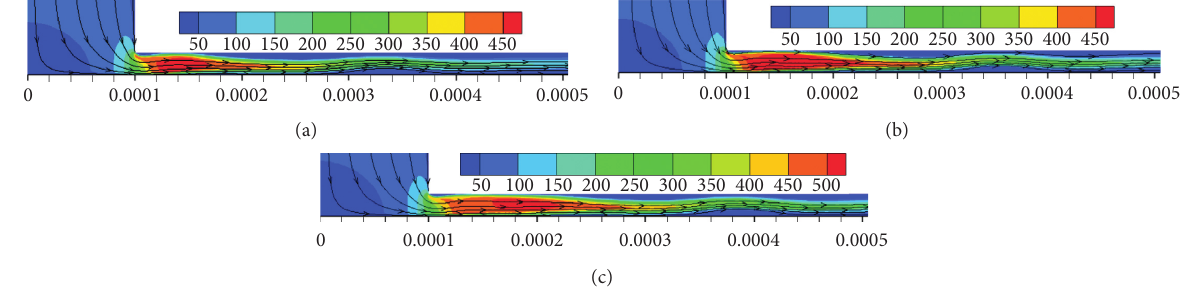
Figure 9: Cloud chart of the velocity of the gas film at different p